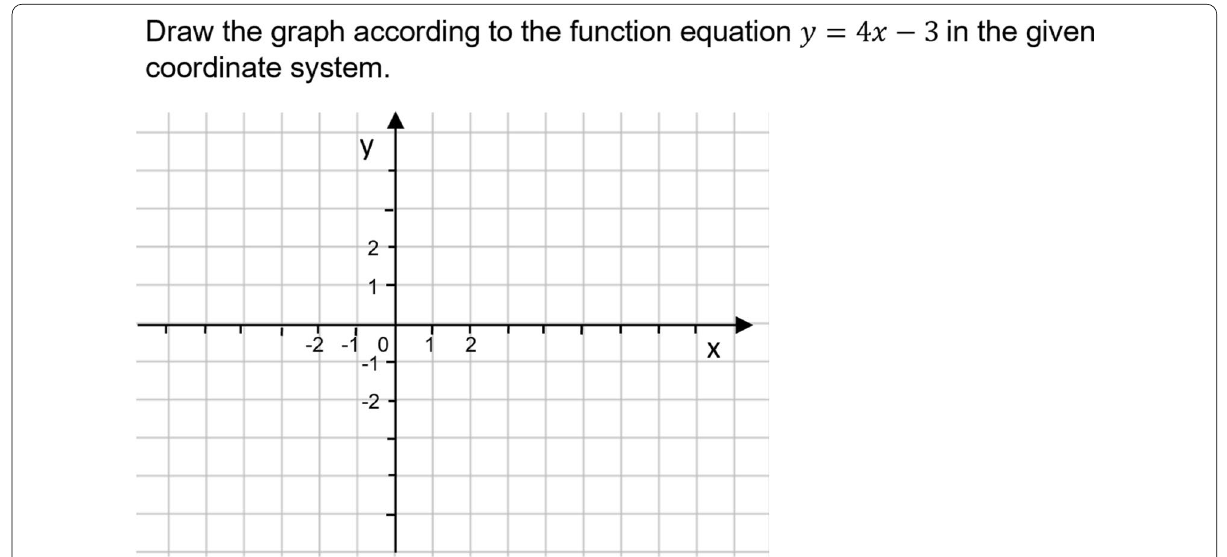
Fig. 5 Sample test item for a change from an equation to a